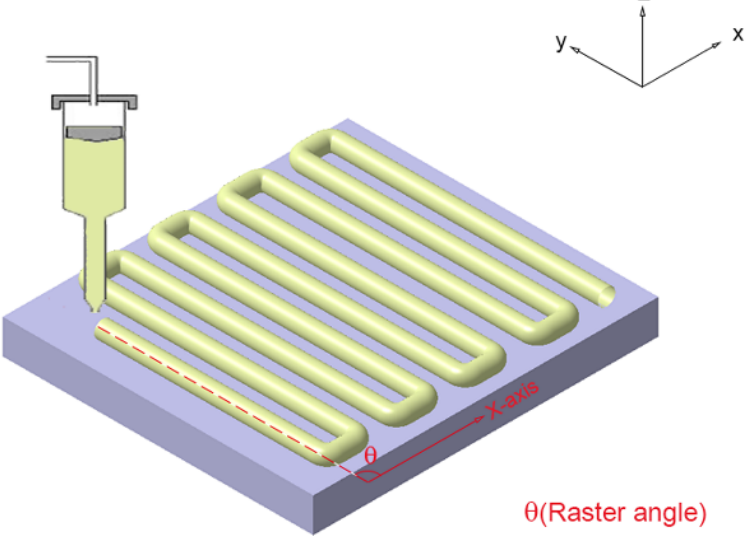
Figure 1. The raster angle of 3D printing.